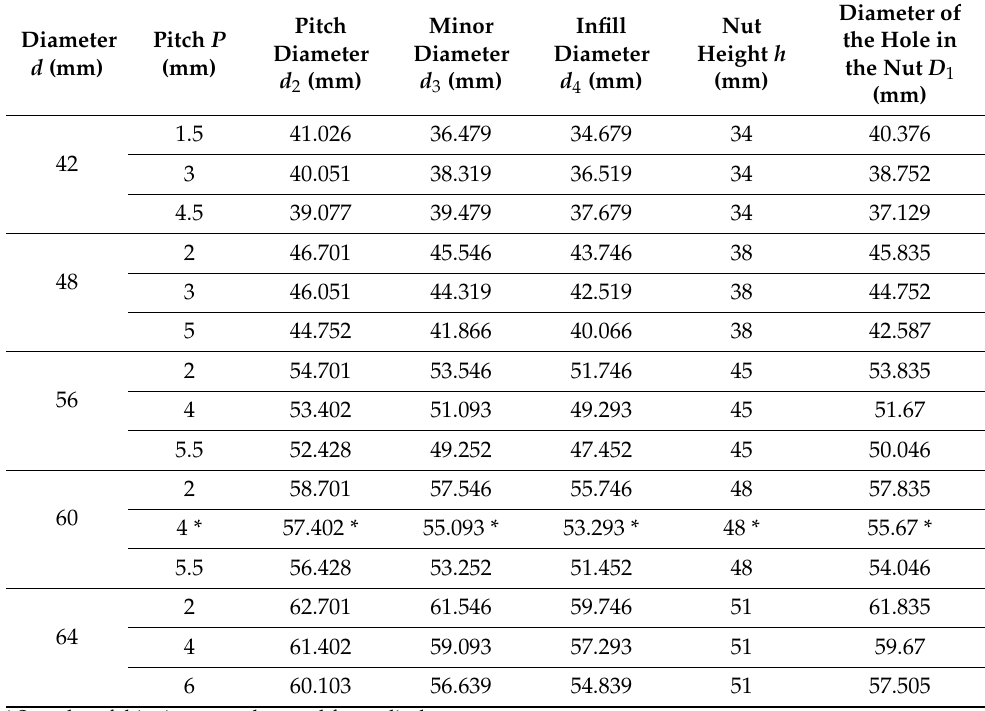
Table 2. Selected parameters of the thread and nuts.